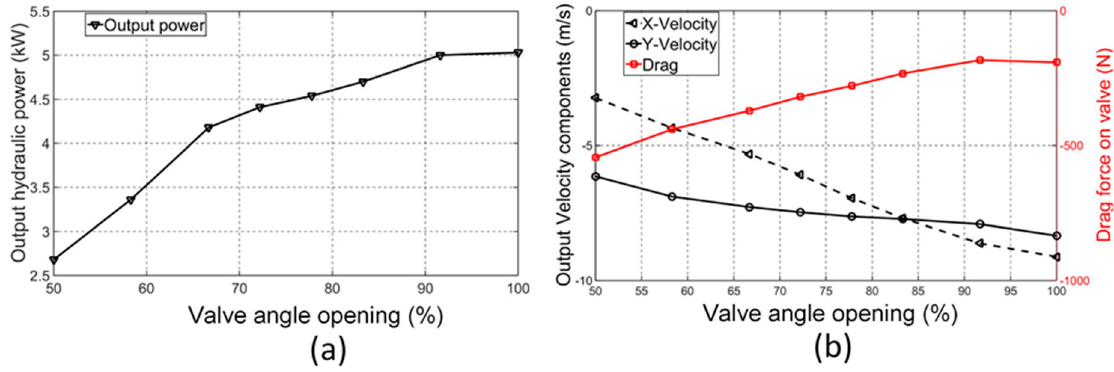
Figure 10. Correlation study between separate nozzle and entire turbine model: ( a ) Output power response; ( b ) Output velocities and drag force responses.